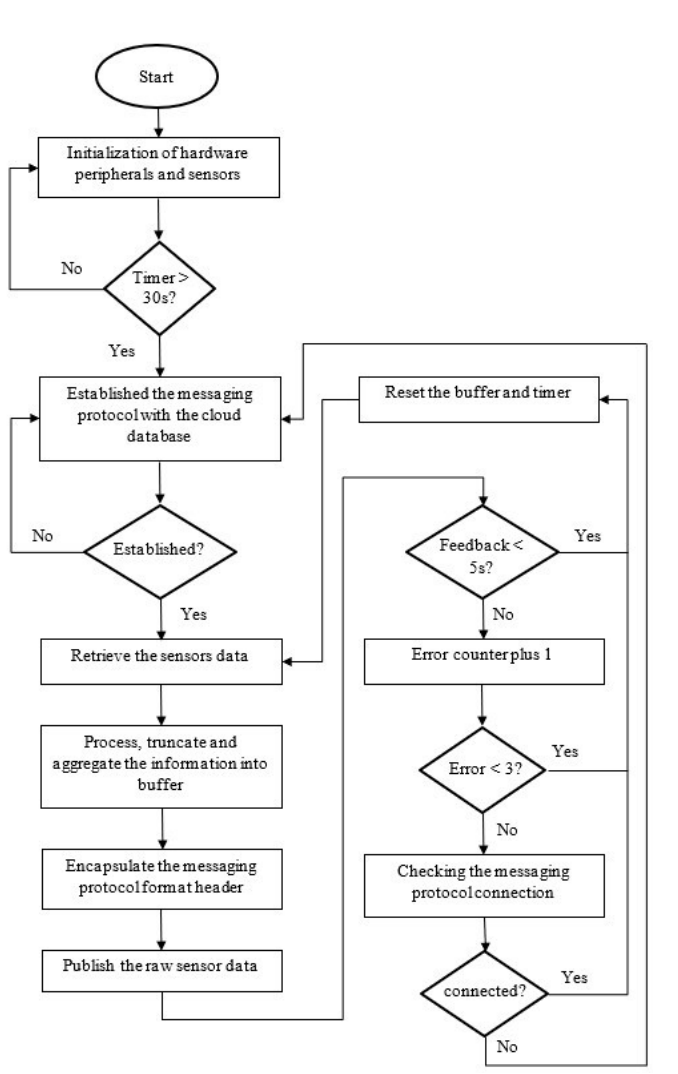
Figure 2. Flow Process of the Overall Operation Sequence.